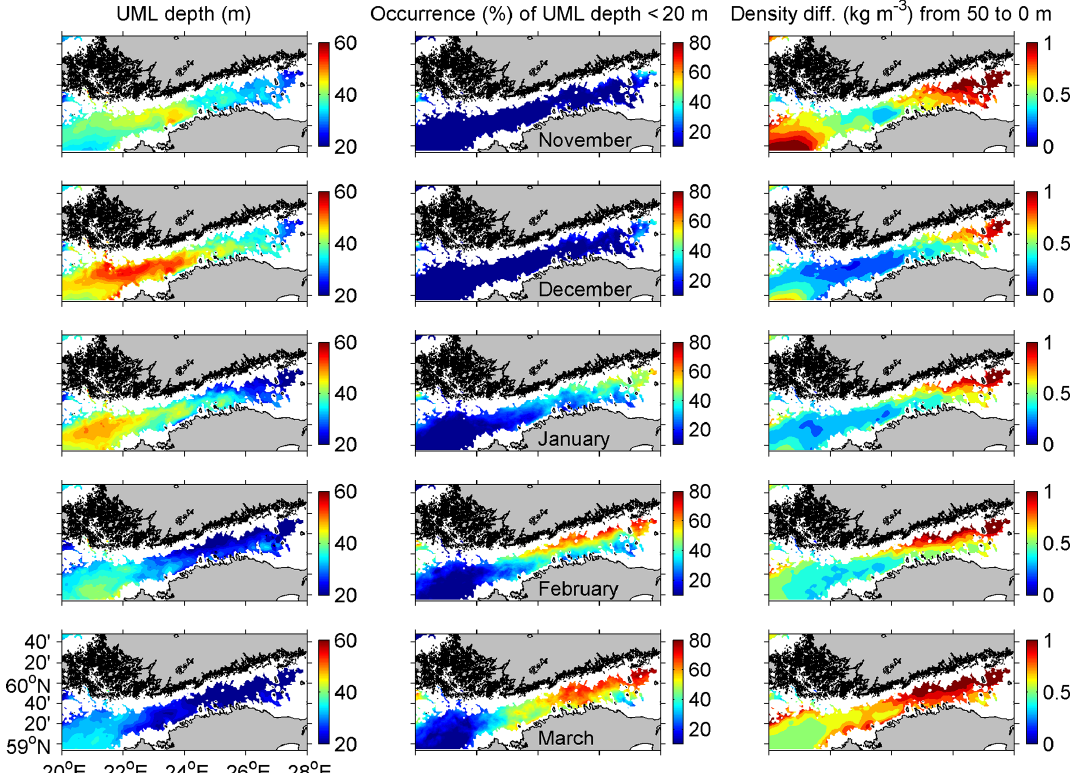
Figure 8. Mean simulated upper mixed-layer (UML) depth, percent occurrence of UML depth < 20m, and density difference between 50 and 0m depth from November to March, 2010 to